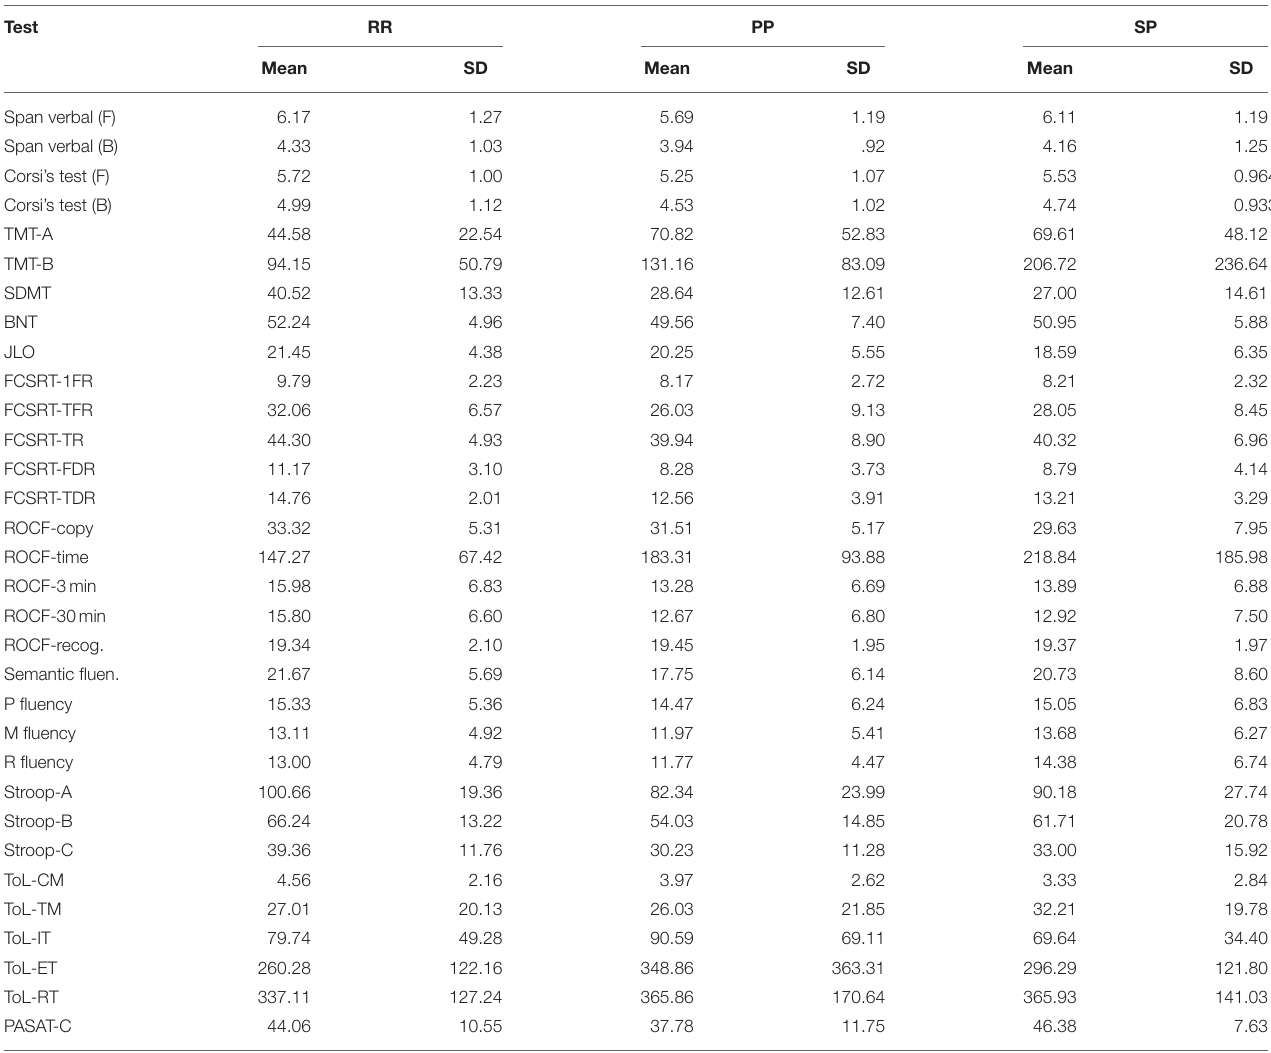
TABLE 2 | Main neuropsychological results by the three sub